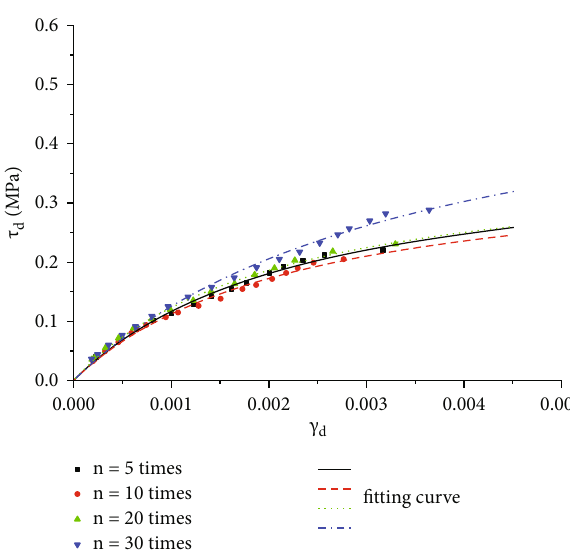
Figure 7: Dynamic stress-strain curves under di ff erent freeze-thaw cycles (-5 ° C).